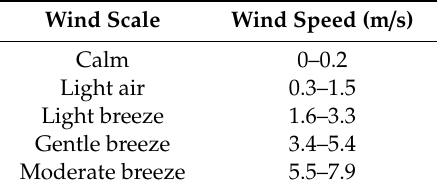
Table 2. Wind scale and wind speed list.